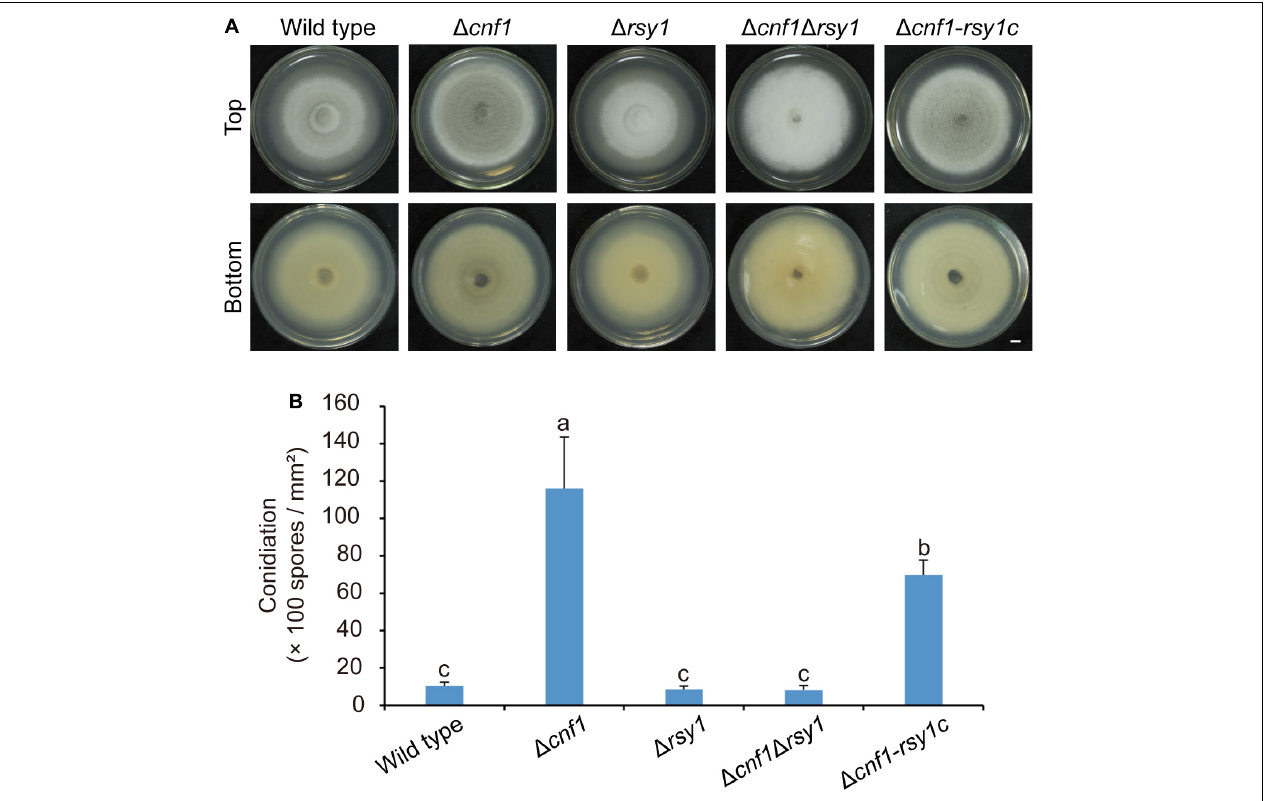
FIGURE 4 | Melanin promotes conidiation in M. oryzae . (A) Images of colonial morphology and color of the wild-type 70-15 and its derived mutants ( (cid:49) cnf1 , (cid:49) rsy1 , (cid:49) c nf1 (cid:49) rsy1 , and (cid:49) cnf1-rsy1c , a complementation strain of RSY1 in (cid:49) c nf1 (cid:49) rsy1 ). Bar = 5 mm. (B) Spore production in the wild-type 70-15 and its derived mutants. Error bars represent ± SD. Different lowercase letters represent significant differences between four strains as estimated by Tukey’s HSD test ( p < 0.05).